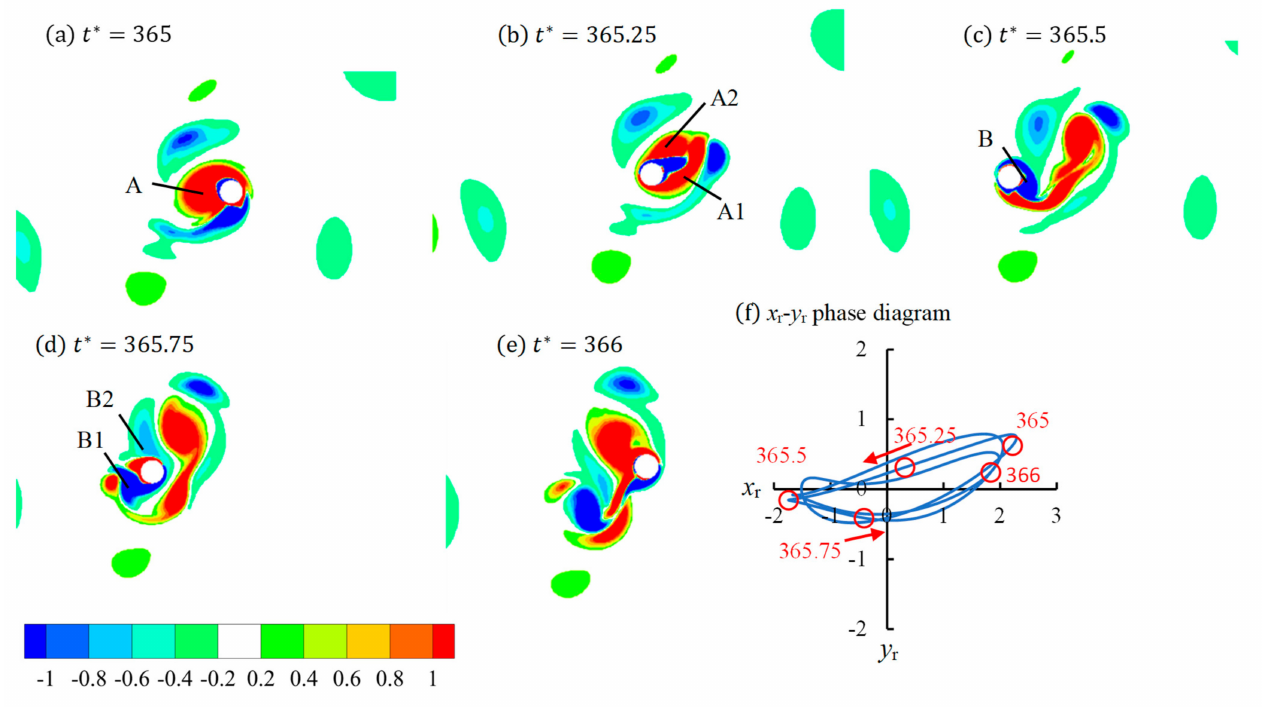
Figure 7. Regime D/F for β = 45 ◦ , KC =10, f ∗ = 0.5 within one period starting from t ∗ = 365. ( a – e ) Contours of vorticity of ( f ) x r - y r phase